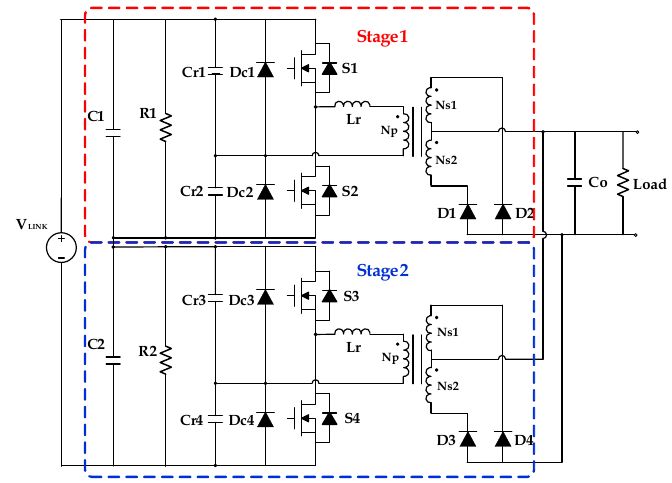
Figure 2. LLC resonant converter with ISOP auto-balancing connection.